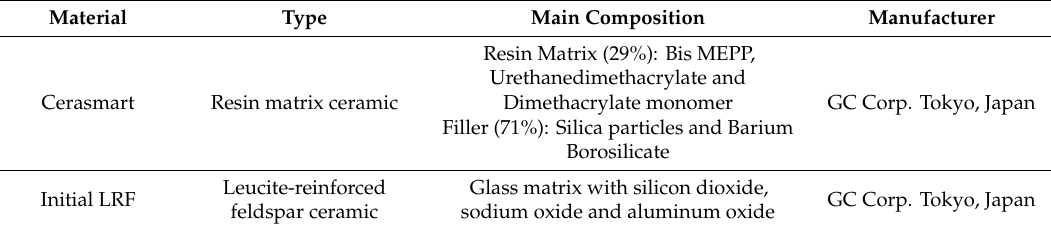
Table 1. Ceramic materials used in the study.